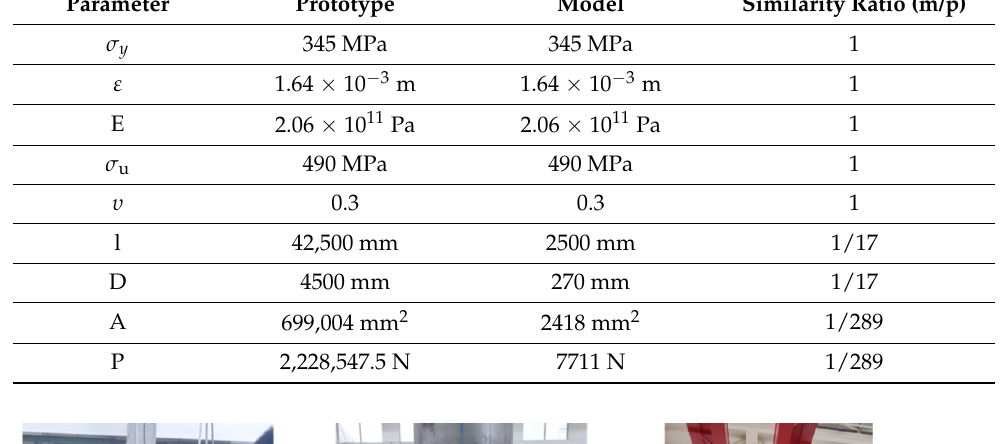
Table 7. Similarity ratio of experimental model.